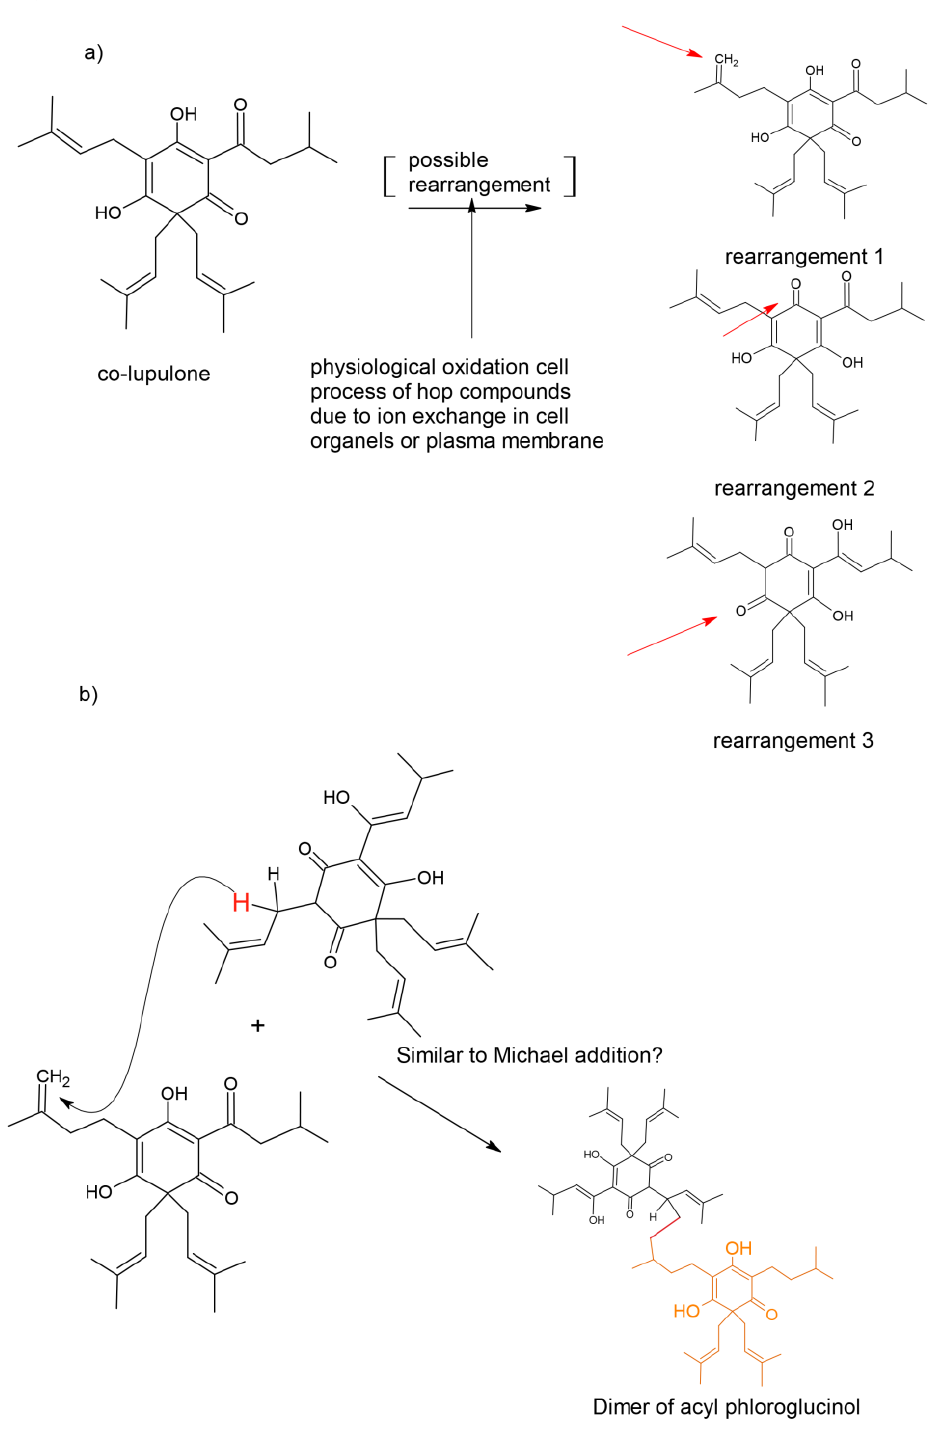
Figure 7. ( a ) Possible oxidation process once the compounds are exposed internally in the cells. Red arrows indicate where changes occurred; ( b ) Plausible interactions of acylphloroglucinols to form dimers, inspired after the proposal of biosynthetic pathways in (23) observed in L. scoparium. Scuotto et al. [27] identified several indole derivatives of umifenovir (arbidol) having a 10-fold improved anti-CHIKV inhibitory activity. The presence of an electron-withdraw- ing substituent, such as a carbonyl group of the phenol ring, yields molecules with more pronounced antiviral effect. A study by Sangeetha et al. [28] exploring the anti-CHIKV capacity of extracted compounds from leaves of Tectona grandis Lin. (Verbenaceae) showed that compounds like benzene-1-carboxylic acid-2-hexadeconate (BCHD) (8) (Fig- ure 8) were 76.46 times more active than ribavirin to treat RSV (Respiratory Syncytial Vi- rus) infection, hepatitis C, and some viral hemorrhagic fevers [28]. The possible interaction of lipophilic chain compounds, like in the case of hops β -acids, could be either by